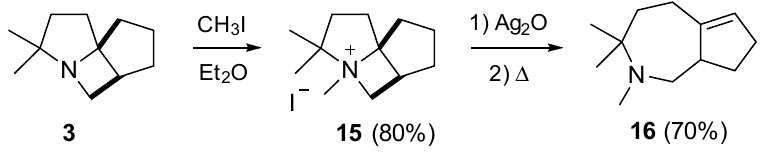
Scheme 11. Methylation of 3 with subsequent Hofmann cleavage of quaternary ammonium hydroxide.